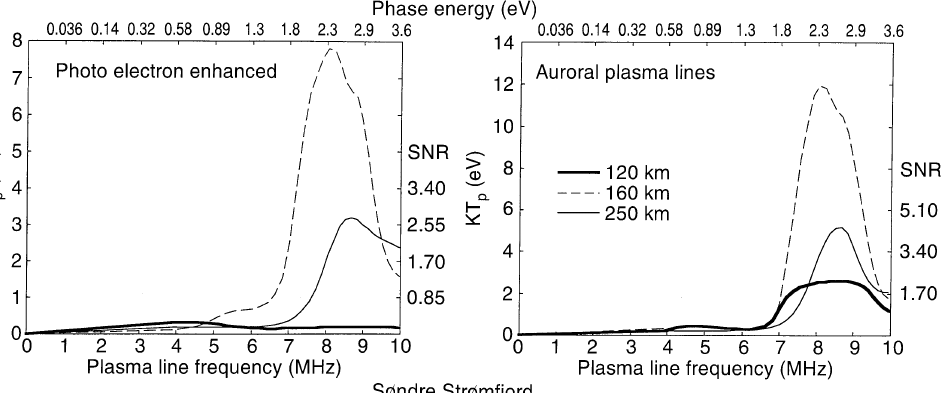
conditions (see text for details). The lower x - axis gives the plasma line frequency, while the upper gives the phase energy for the reso- nant electrons (for comparisons with Fig. 1)